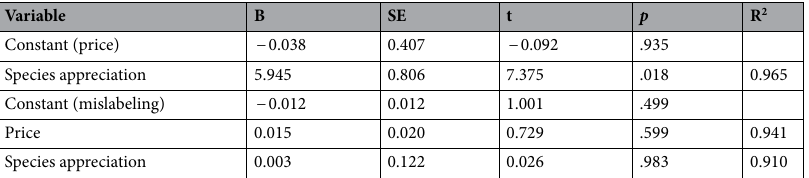
Table 3. Regression analysis of the variables mislabeling (dependent), price (expected mediator) and consumer’s appreciation (independent). Unstandardized regression coefficients (B) and their standard error (SE), t statistics and its p -value, and R 2 of the partial correlation. Zero-order regression predicting price from consumer’s appreciation above; below, multiple regression results of the three